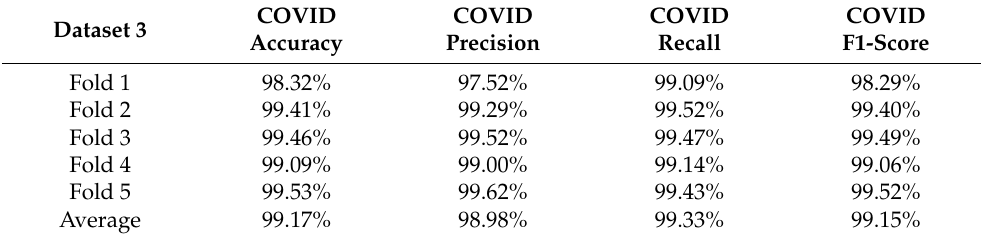
Table 8. COVID accuracy of dataset 3.